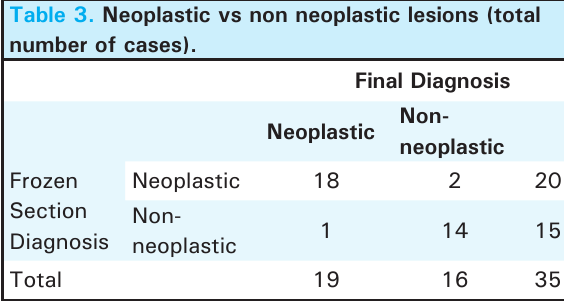
Table 2. Overall concordance rate of frozen section with histopathological reports.